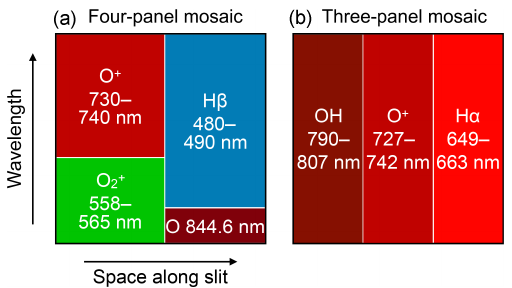
Figure 1. Diagrams showing the different wavebands of some mo- saic interference filters used with HiTIES. The four-panel mo- saic (a) has been in use for most seasons between 2003 and 2015; the three-panel mosaic (b) has been in use since December